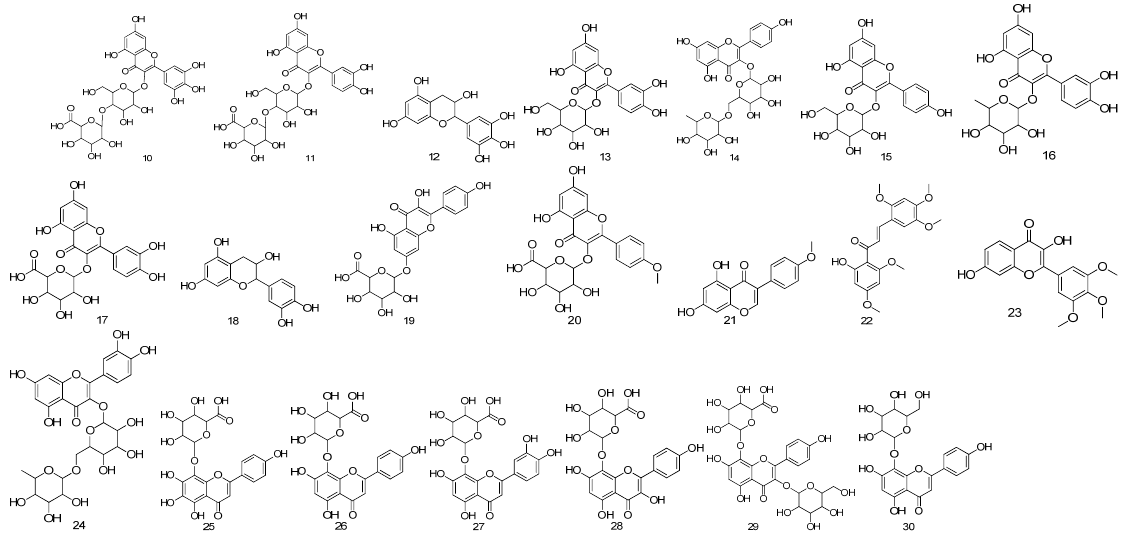
Figure 3. The chemical structures of flavonoids identified from Fructus Malvae . Table 3. The sterol compounds identified from Fructus Malvae .